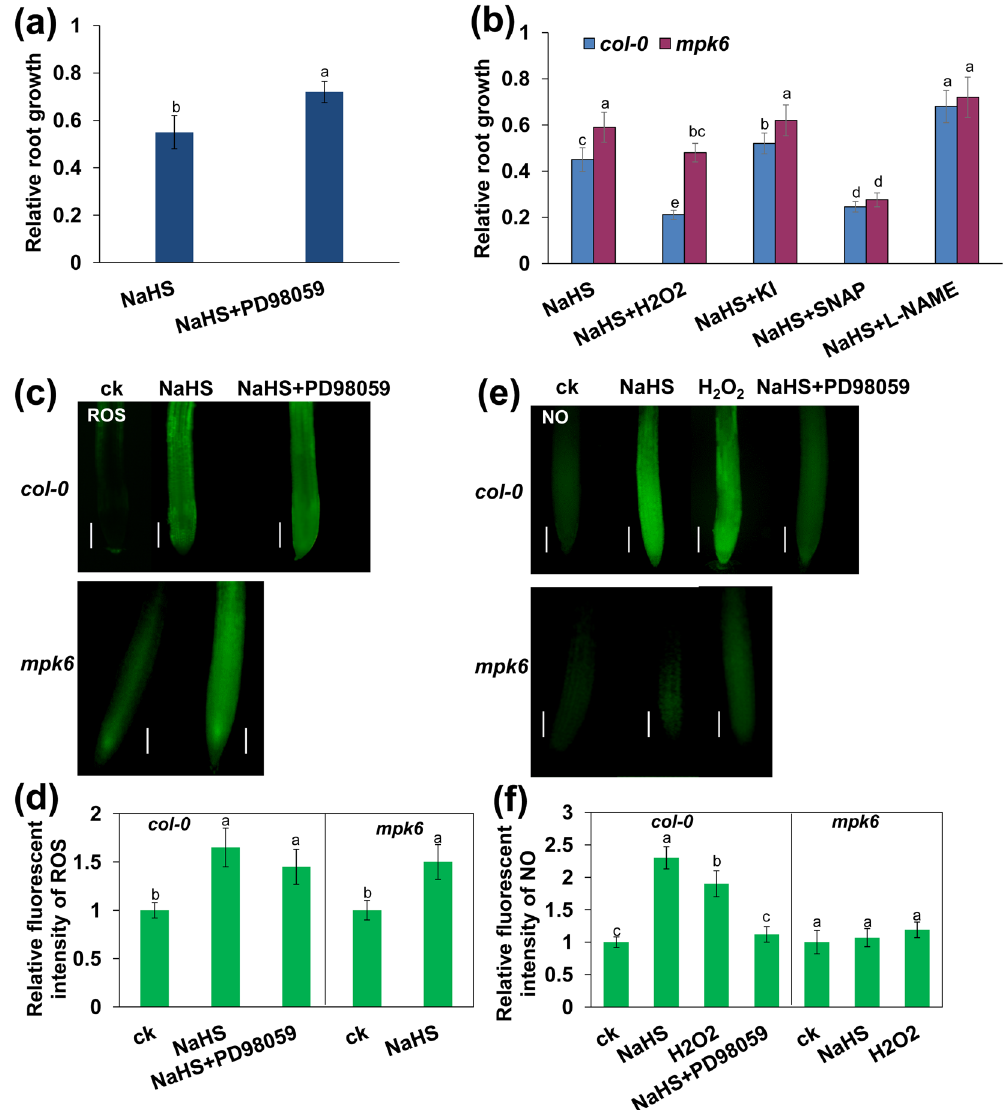
Figure 6. MPK6 mediates PR growth inhibition by NaHS. ( a ) Relative root growth of Col - 0 seedlings treated with 500 μ M NaHS in the presence or absence of 150 μ M PD98059 for 2 d compared with untreated seedlings. ( b ) Relative root growth of Col - 0 and mpk6 seedlings exposed to 500 μ M NaHS with or without 1 mM H 2 O 2 , 100 μ M SNAP, 1 mM KI, and 500 μ M L-NAME for 2 d compared with untreated seedlings. n = 45. ( c , d ) Detection of ROS production in the roots of 5-d-old wild-type col - 0 and mpk6 seedlings exposed to 500 μ M NaHS with or without 150 μ M PD98059 for 24 h by the ROS-specific fluorescent probe DCFH-DA ( c ) and the quantification of the ROS-specific fluorescence intensities ( d ) in plants treated as described in ( c ). ( e , f ) Detection of NO production in the roots of 5-d-old wild-type col - 0 and mpk6 seedlings exposed to 500 μ M NaHS with or without 1 mM H 2 O 2 or 150 μ M PD98059 for 24 h using the NO-specific fluorescence probe DAF-2 DA ( e ) and quantification of NO-specific fluorescence intensities ( f ) in plants treated as described in ( e ). n = 30. Bars, 100 μ m. ck, untreated control. Error bars represent ± SD. Different letters indicate significantly different values (P < 0.05 by Tukey’s